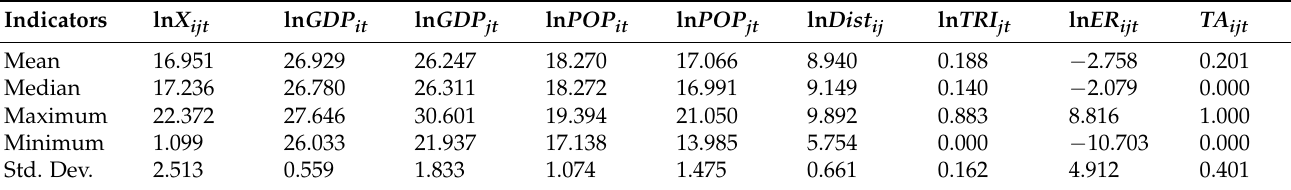
Table 2. Descriptive Statistics.